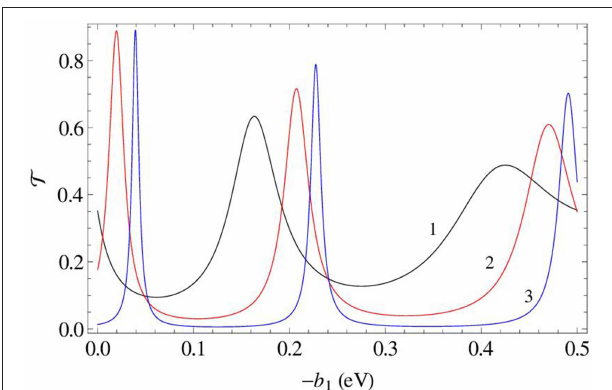
b 1 plotted for FIGURE 4 | Transmission amplitude T as a function of bias − parameter values: E 0.1 eV, a 1 0.5 eV, a 2 0.1 eV, d 1 2 nm, = = = − = d 2 ν 1 10 nm. Computations have been carried out with powers µ 1 1 = = = (point P 1,1 ) and µ 2 2, ν 2 1 (point P 2,1 ). Squeezing scenario is displayed = = for ε 0.5 (curve 1, black), 0.25 (curve 2, red), and 0.1 (curve 3, blue). = b 1, n Location of all three peaks converges to set defined by Equation (85) {− } with n